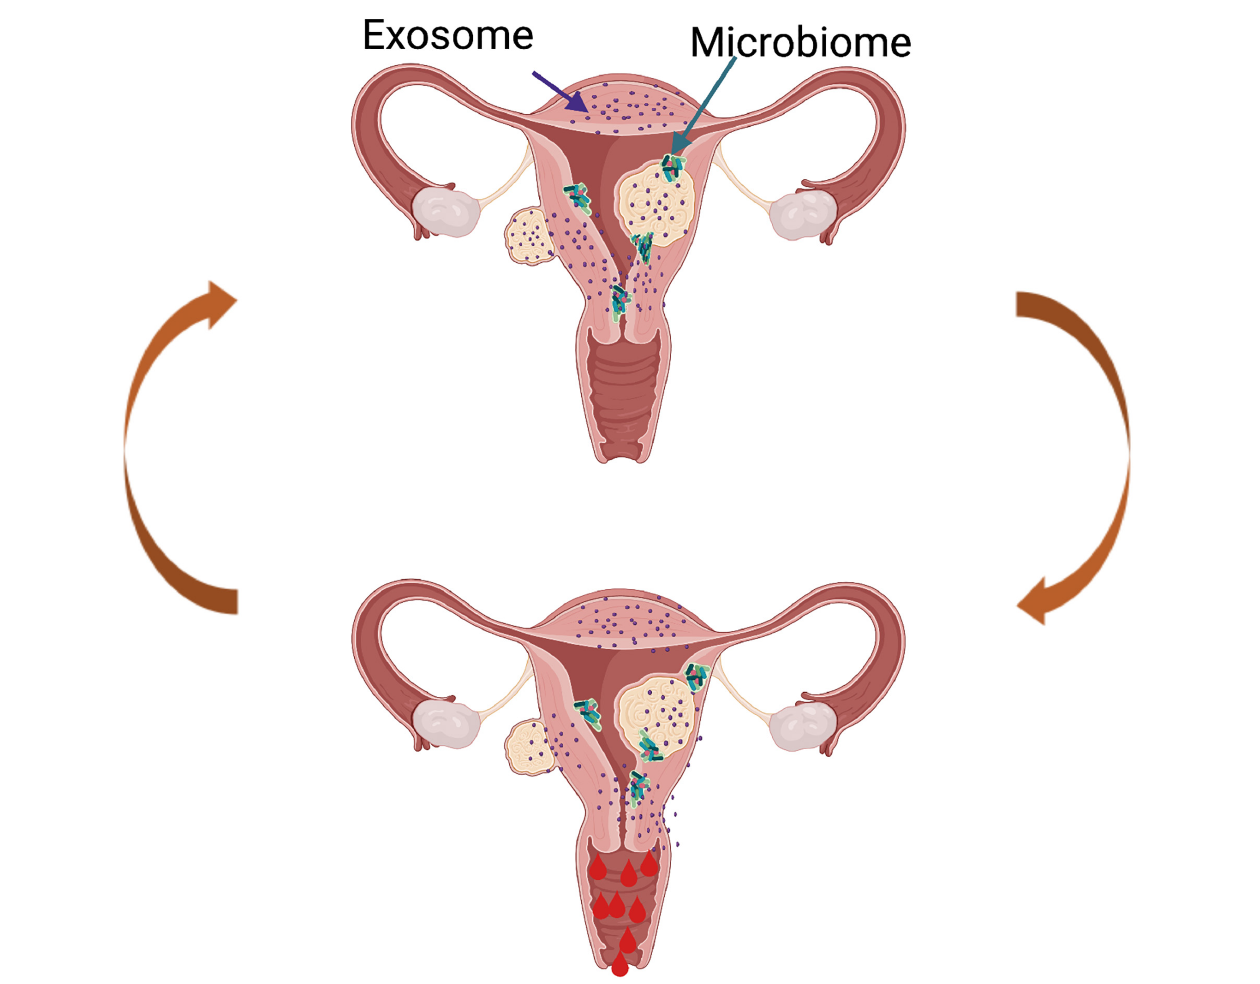
FIGURE 5 | Proposed model of future directions in the uterine fibroid (UF) field. The presence of UFs causes alterations in the healthy endometrial microbiome and changes in the exosome content, leading to increased factors involved in cell proliferation, angiogenesis, and inflammation, among others. This creates a vicious cycle contributing to increased and prolonged heavy menstrual bleeding in women with